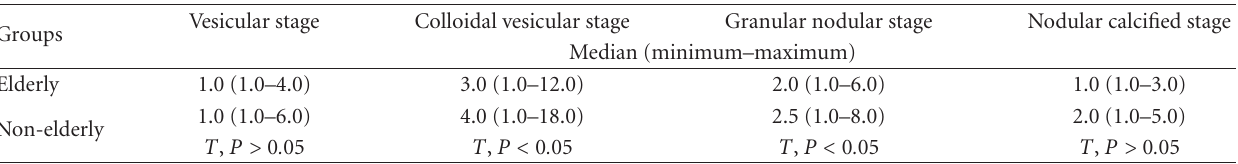
Table 2: Comparison of the inflammatory infiltrate in relation the evolutionary stage of the cysticerci in brain of non-elderly and elderly patients with cysticercosis.